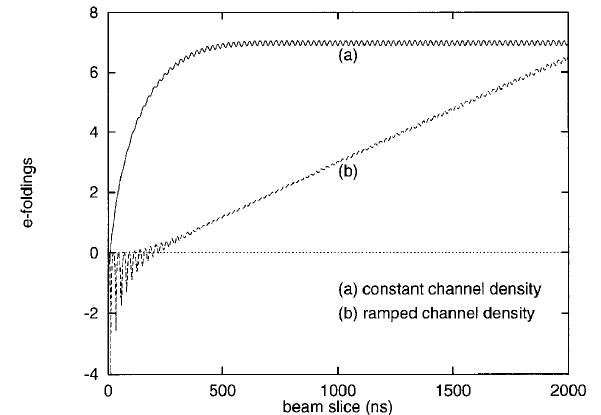
equations.FIG. 2. Amplitude of beam displacement at the end of the accelerator ( ‘ (cid:5) 50 m ) for ( a ) constant channel density and ( b ) linear ramp channel density (from numerical integration of linear model